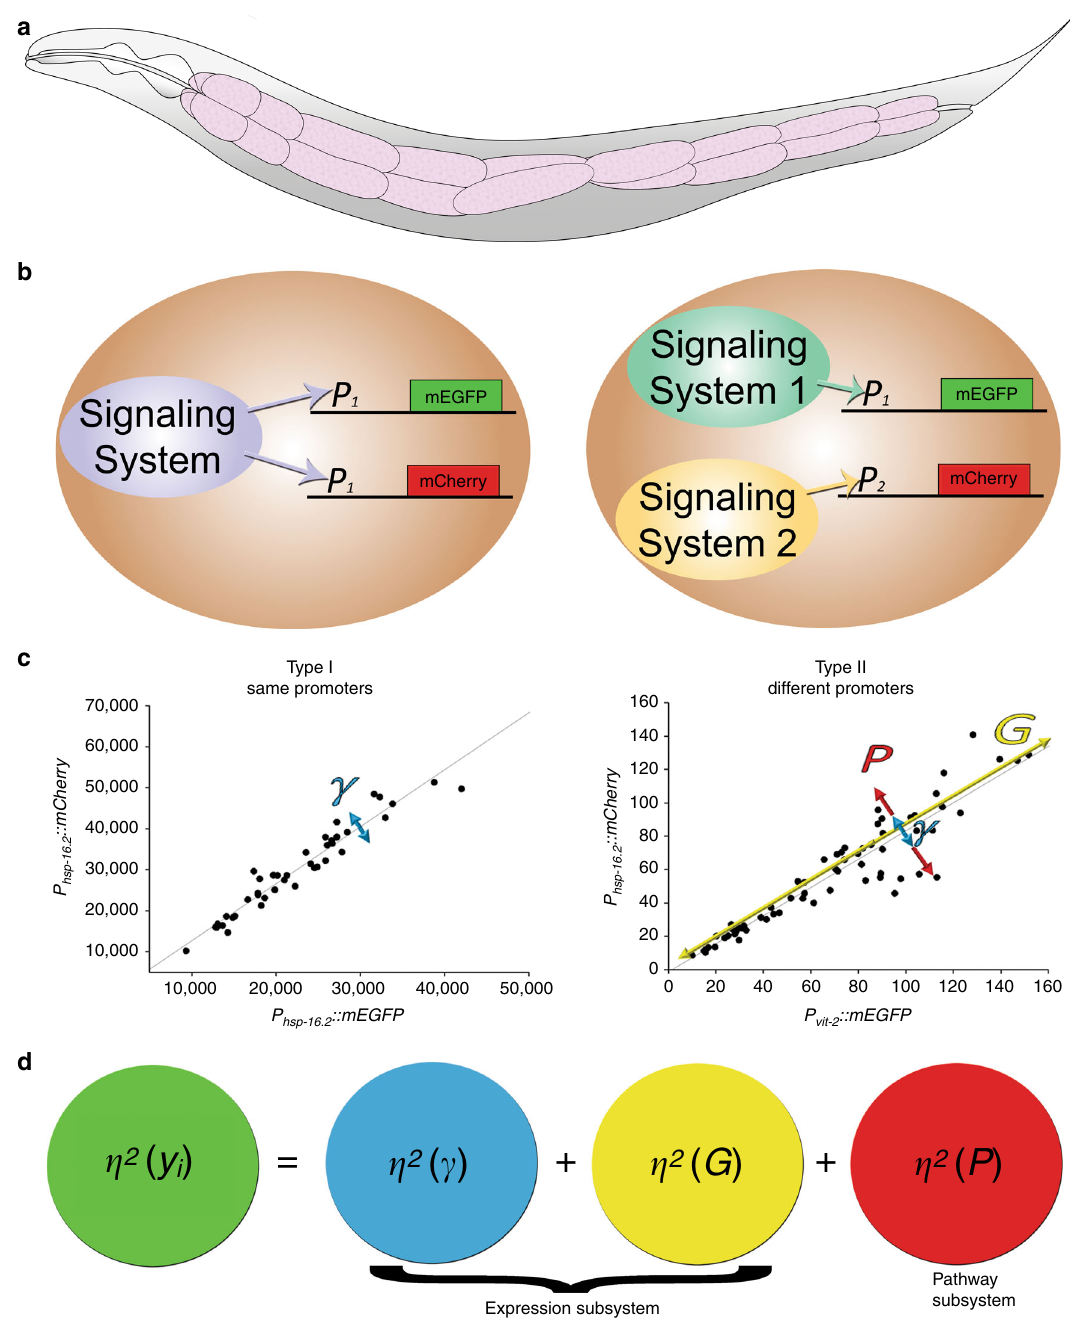
Fig. 1 Experimental design and analytical framework. a Schematic view of the C. elegans body. Intestine is colored pink. The twenty cells of the intestine are organized into nine segments, called rings. b Overview of reporter gene measurement scheme. In the left panel, two differently colored copies of the same gene respond to the same signaling system (Type I experiments), or, in the right panel two differently colored reporters controlled by two different promoters respond to two distinct signaling systems (Type II experiments). c Data collection schematic. We imaged intestine cells in rings one through four (the cells that fi t in a single fi eld of view with a ×40 objective) in animals on day two of adulthood, at the point when lifespan can be predicted from P hsp-16.2 ::gfp expression levels. We then plotted expression levels of reporter pairs expressed in the intestine cells, grouped by cell type; the same cell types (e.g., cells in ring three; int3 cells) from different animals are plotted. Left scatterplot shows typical results of type I experiment. Since both genes receive the signals from the same upstream regulators and share the same downstream expression machinery, uncorrelated variation of expression results only from stochastic noise of transcription/translation or variable allele access η 2 ( γ ) . Right scatterplot shows typical results of type II experiment. In the case of two different genes, uncorrelated variation of expression can result from stochastic noise of transcription/translation or variable allele access η 2 ( γ ) , and variation in activation of particular signaling pathways η 2 (P) . Correlated variation results from variation in shared gene expression machinery η 2 (G) . d A simpli fi ed version of the analytical framework derived from Colman-Lerner et al 2005 is shown. It depicts the three experimentally tractable bins into which we can attribute cell-to-cell variation in gene expression. Each bin has different underlying molecular causes and is colored differently; η 2 ( γ ) is red, η 2 (P) is blue, and η 2 (G) is yellow. A complete, mathematically detailed description of the analytical framework is shown in Supplementary Notes 1 –